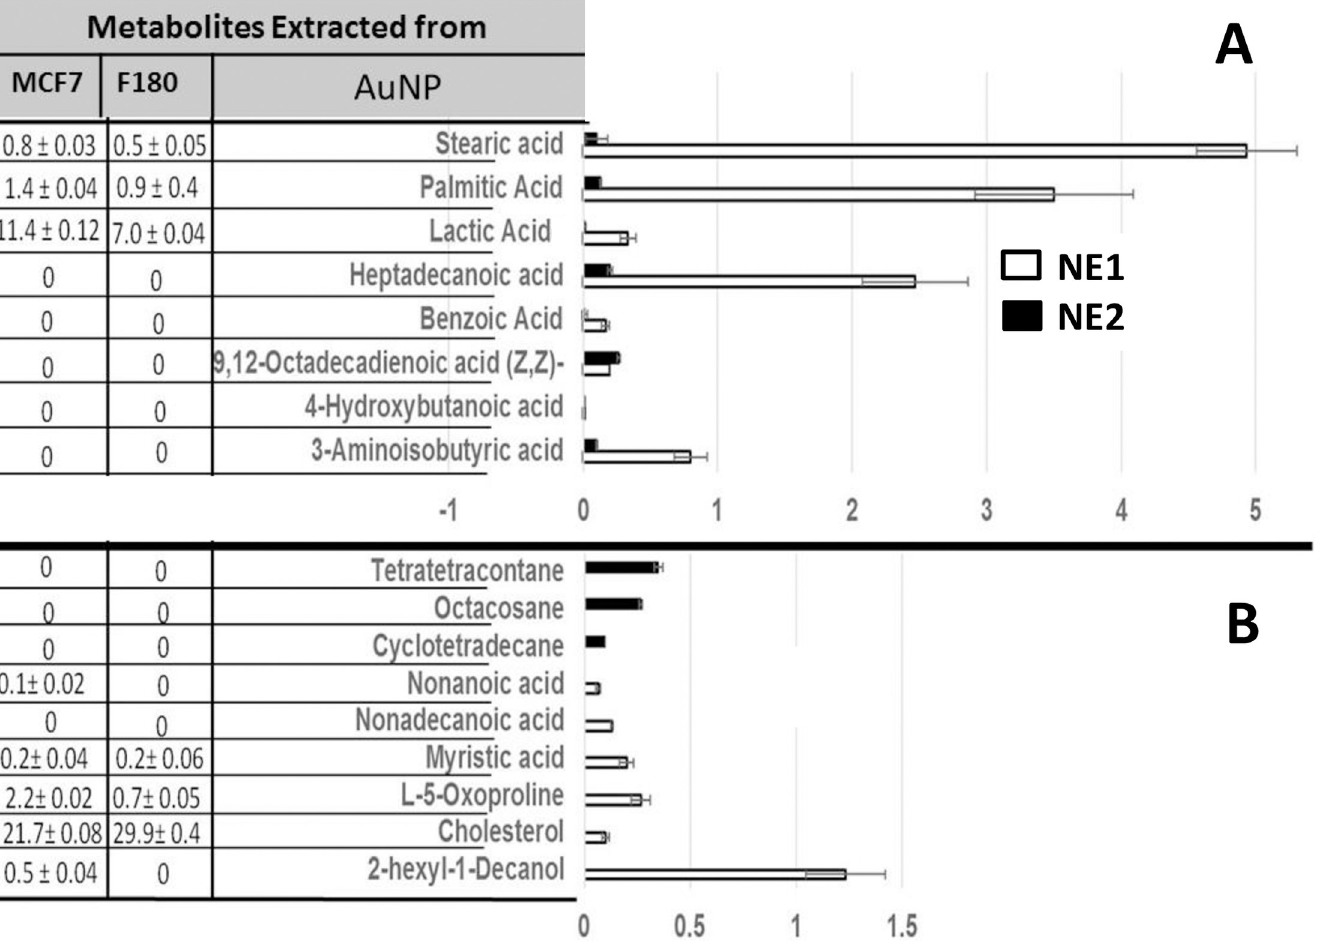
Fig 7. Identification of AuNPs-capping metabolites. NPs solution was centrifuged and the NPs were collected and washed by PBS two times prior to extraction using methanol and sonication for 15 min. The extracted metabolites were analyzed by GC-MS and compared to those extracted from NP-free supernatants. (A) Metabolites were identified from NPs and shared between F180 and MCF7 cell lines. (B) Unique metabolites identified from NPs developed from MCF7 versus those developed from F180. The data display the mean of the percentage of the metabolites ± SEM of three replicas. The table on the left represented the comparison between the identified metabolites from NPs to those identified in Figs 2 and